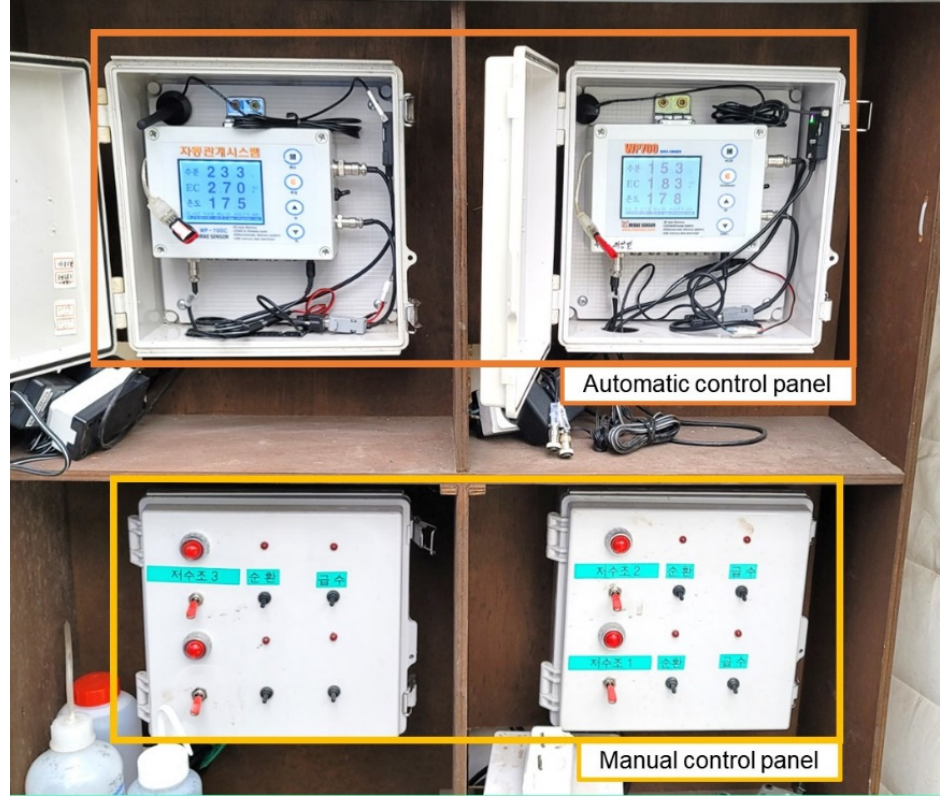
Figure 5. The picture of the control panel in the experiment.